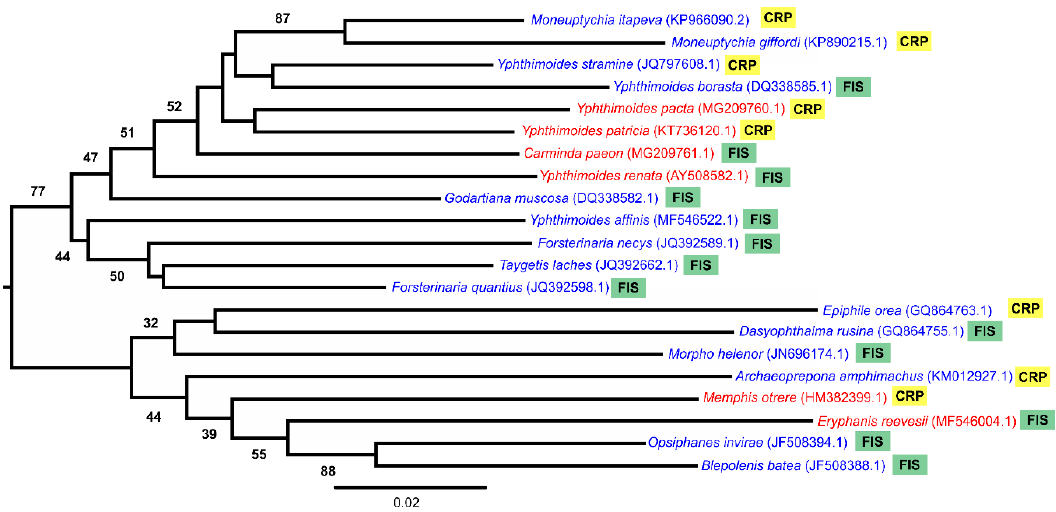
Figure 5. Neighbor joining (NJ) tree showing the phylogenetic relationship of fruit-feeding butterflies with distinct CTmax and habitat occurrence. In red, species with higher thermal tolerance, and in blue, species with lower thermal tolerance, followed by habitat occurrence. CRP = campo rupestre and FIS = forest islands. GenBank accession number inside brackets at tips; numbers above/below branches are bootstrap values.